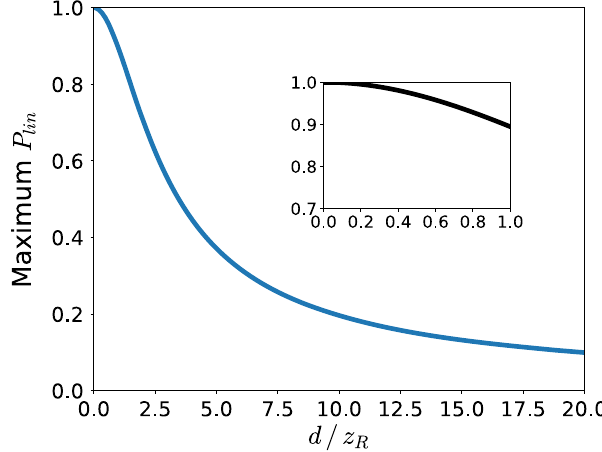
FIG. 7. Degree of linear polarization as a function of the distance between two cross-polarized sources, normalized by the Rayleigh range of the radiation. The two sources have the same amplitude and are completely linearly polarized. Insert: zoom for d=z < 1 . One can see that the maximum P R lin obtainable depends critically on the distance between the sources, as the phase difference along the wavefront becomes more critical if the distance becomes larger than the Rayleigh